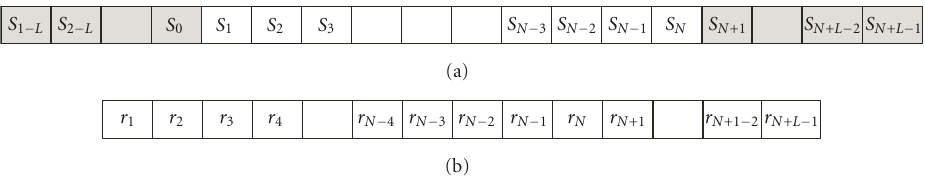
Figure 2: Transmitted (a) and received (b) data block structures. The shaded blocks contain known tail symbols.